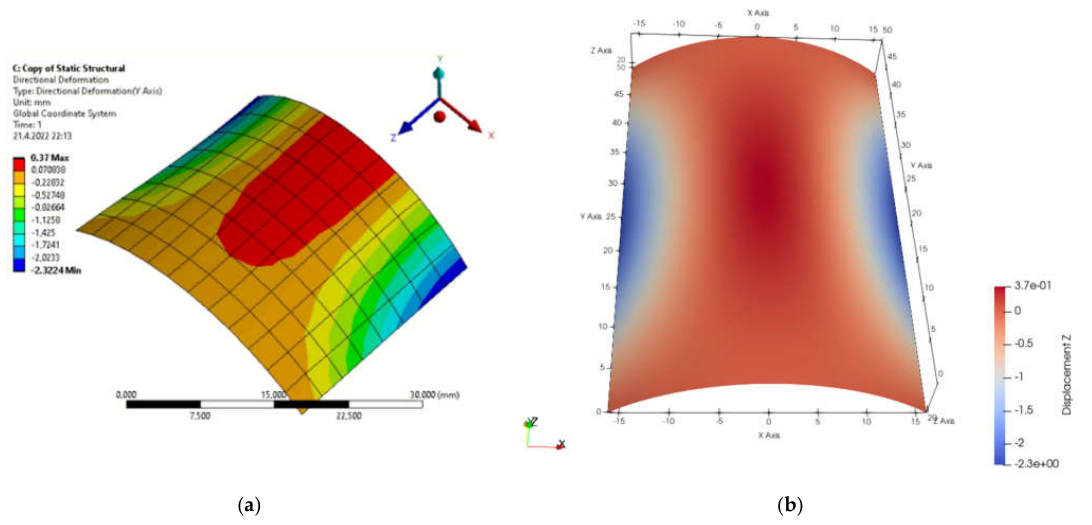
Figure 10. Displacements in load direction ( a ) FEM program; ( b ) MATLAB.